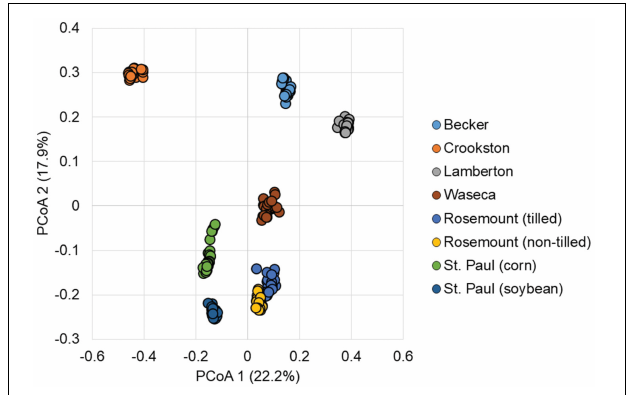
FIGURE 2 | Principal coordinate analysis of Bray–Curtis dissimilarity matrices among all samples ( r 2 = 0.76).